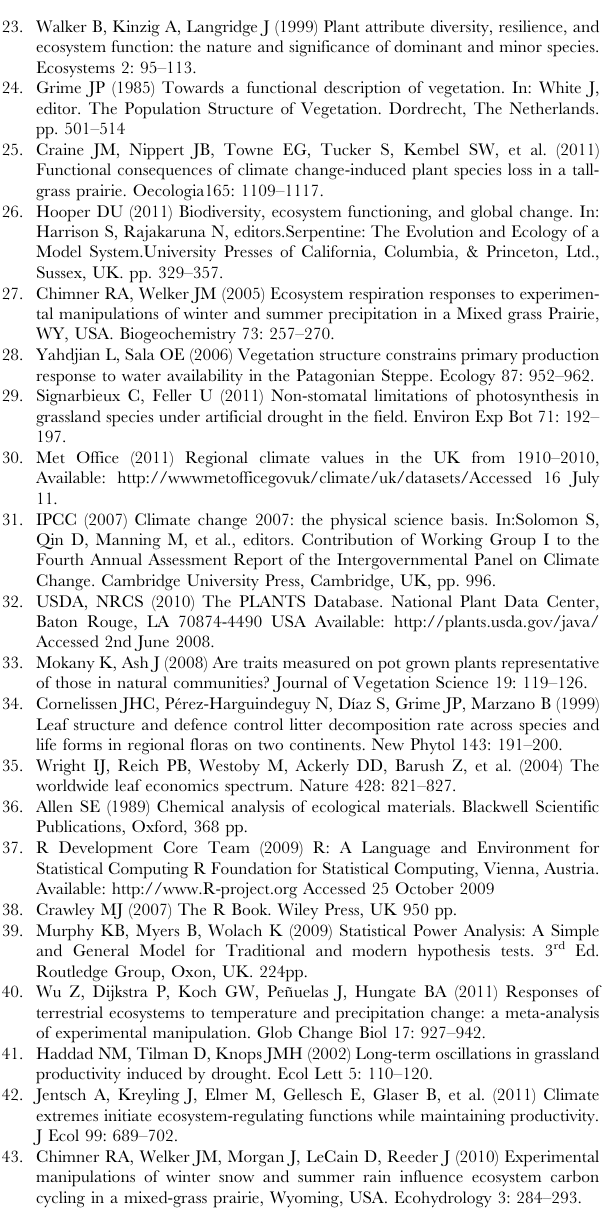
to the presence of the functional group in question, PC to the precipitation change